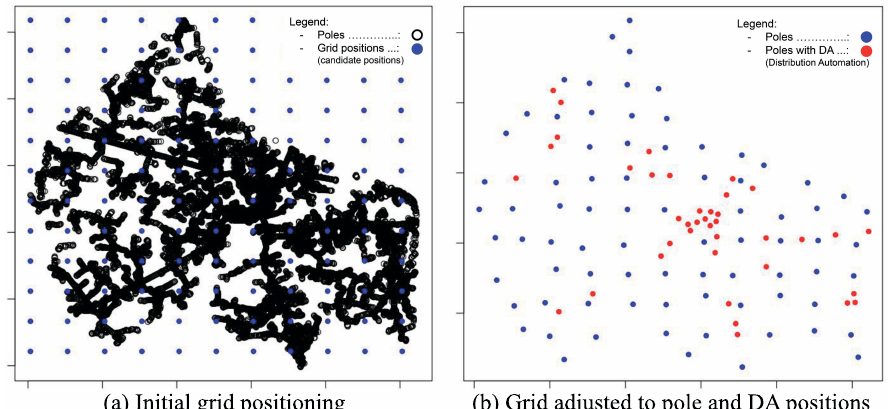
Figure 4. Initial grid and candidate positions